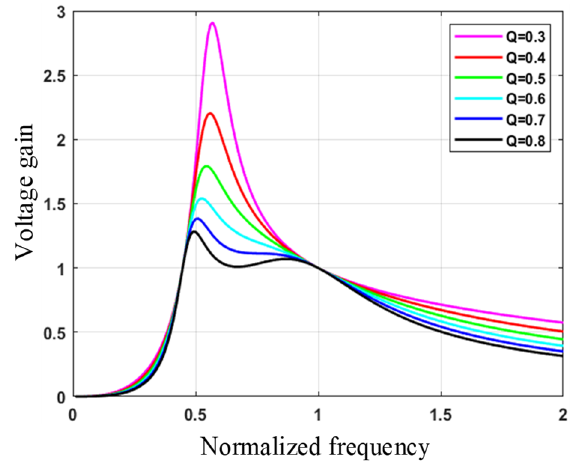
Figure 7. Voltage gain at different Q values ( k = 2).